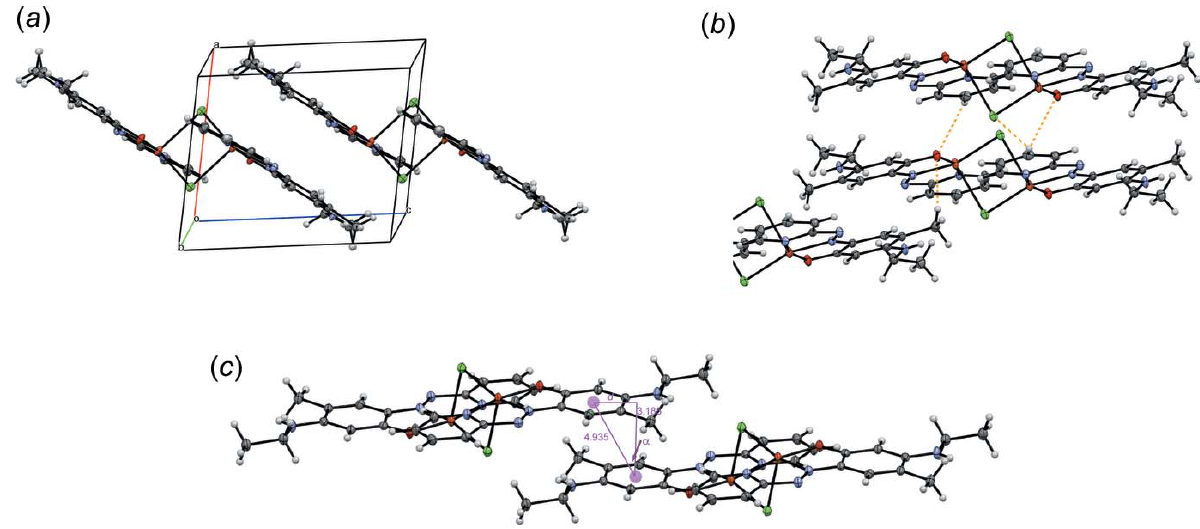
Figure 4 Crystal packing of 3 ( a ), showing intermolecular hydrogen bonds ( b ) and phenyl–phenyl (cid:2) – (cid:2) stacking interactions ( c ) ( (cid:5) is the angle between the ring normal and centroid–centroid vector, d is the displacement between the rings).